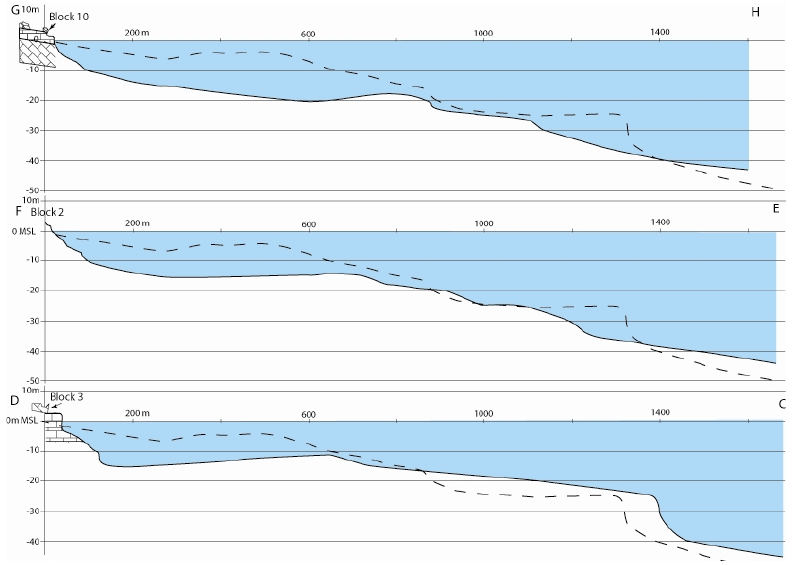
Fig. 3. Bathymetric profiles on seaward side of boulder accumulations, compared with profile A–B (cf. Fig. 2), indicated as dashed line, devoid of megaclast deposits.